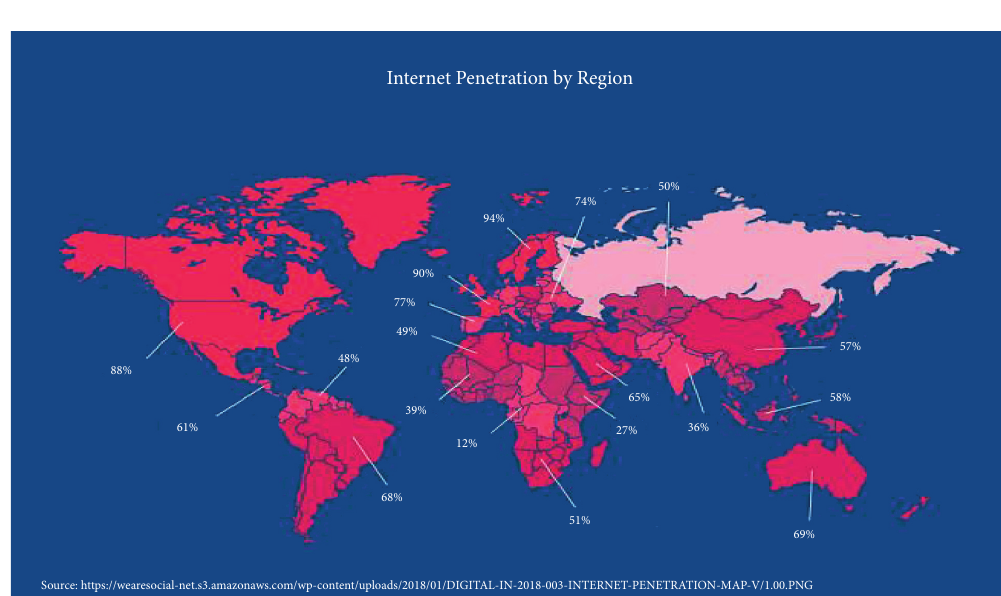
Figure 2: A map of the internet usage distribution in the world’s continents ([17]: Global Digital